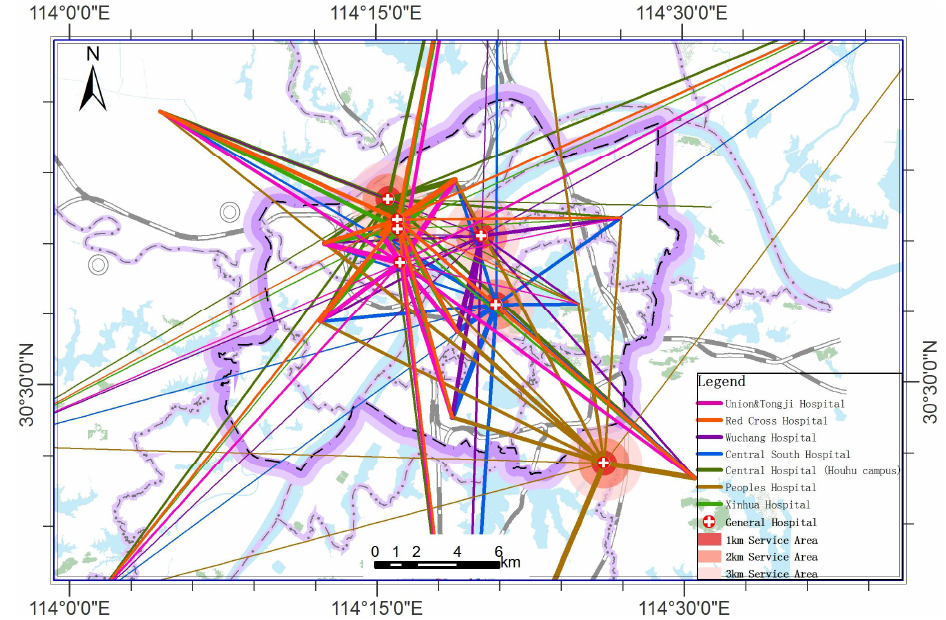
Figure 9. The map of visitors’ mobility and cross-infection risk in general hospitals. Table 4. Proportions of visitors to general hospitals reside in each administrative district.